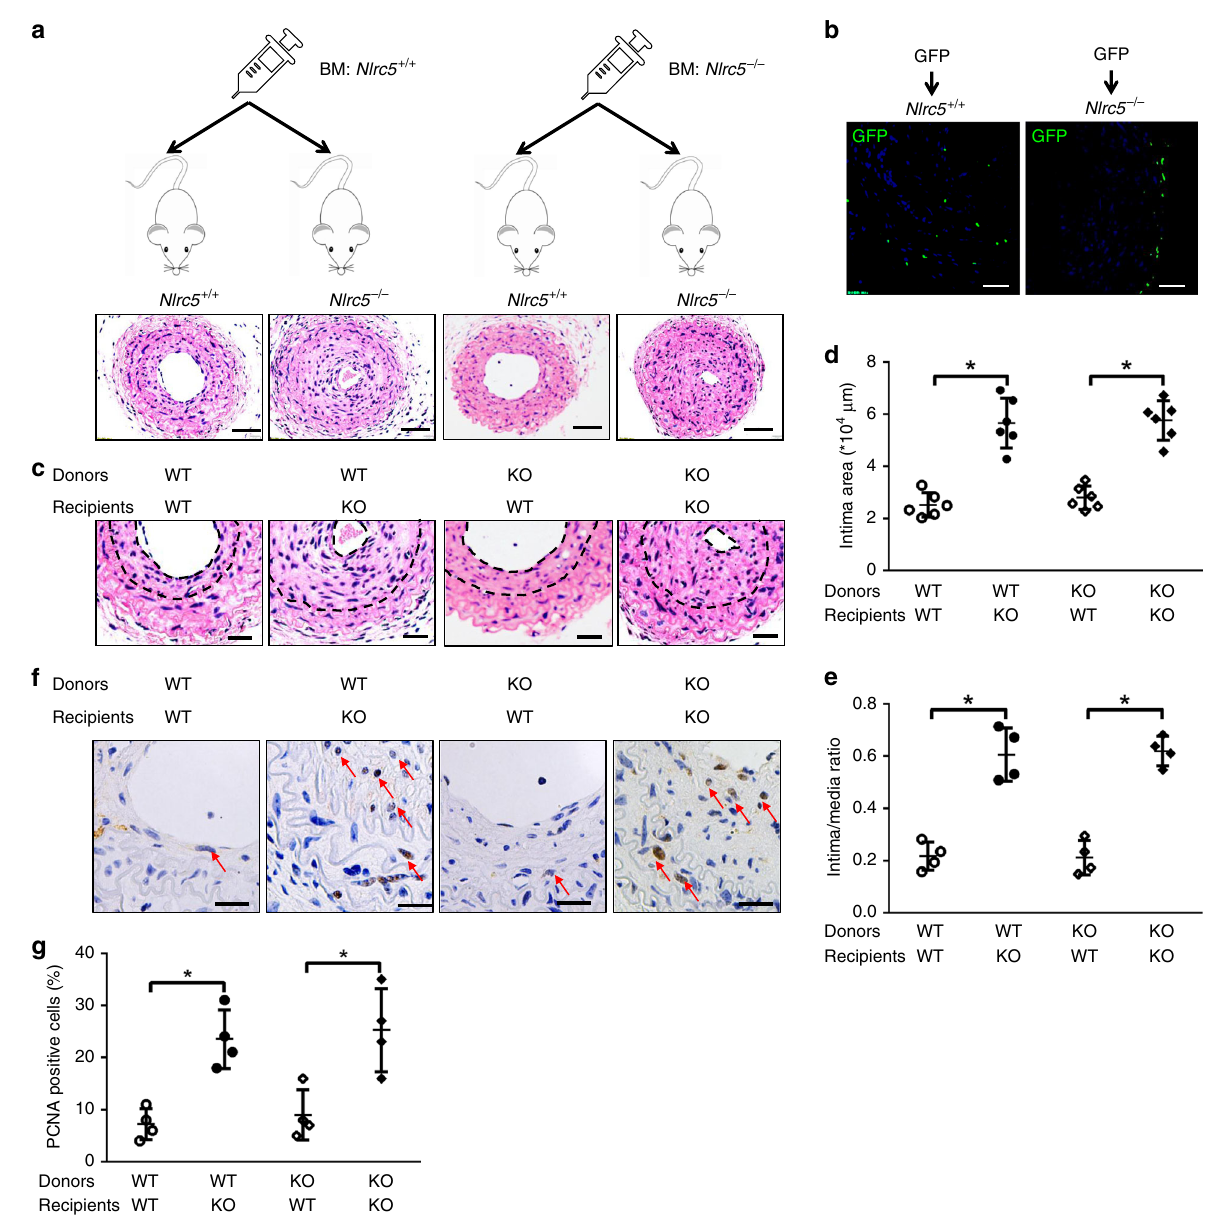
Fig. 7 NLRC5 de fi ciency in BM-derived hematopoietic cells does not affect neointimal formation. a BM transplantation strategy. Bone marrow-derived cells from Nlrc5 + / + and Nlrc5 + / + mice were transplanted to Nlrc5 + / + and Nlrc5 − / − mice following irradiation. Scale bar: 100 μ m. b Representative immuno fl uorescence images of ligated carotid arteries from Nlrc5 + / + and Nlrc5 − / − mice transplanted with GFP transgenic BM-derived cells. GFP signals (green) from BM-derived cells are detected in ligated carotids. The nuclei are stained with DAPI (blue) ( n = 3 per group). Scale bar: 100 μ m. c Representative images of hematoxylin/eosin-stained carotid arteries of Nlrc5 − / − and Nlrc5 + / + recipients harboring Nlrc5 − / − or Nlrc5 + / + BM-derived cells at 3 weeks after carotid ligation. Scale bar: 50 μ m. d , e Quanti fi cation of the intima area and intima/media ratio in the histological sections ( n = 4 per group). f , g Immunohistochemistry staining (red arrow) and quantitative analysis of PCNA-positive cells in the carotids of Nlrc5 − / − and Nlrc5 + / + recipients harboring Nlrc5 − / − or Nlrc5 + / + BM-derived cells at 3 weeks after carotid ligation ( n = 4 per group). Five fi elds per section from each sample are analyzed. Scale bar: 20 μ m. Two-tailed Student ’ s t -test was used to compare two groups ( d , e , and g ). Data are presented as mean ± SD. * P < 0.05. Original magni fi cation, ×200 ( a ) and ×400 ( b , c , and f ). Source data are provided as a Source Data fi